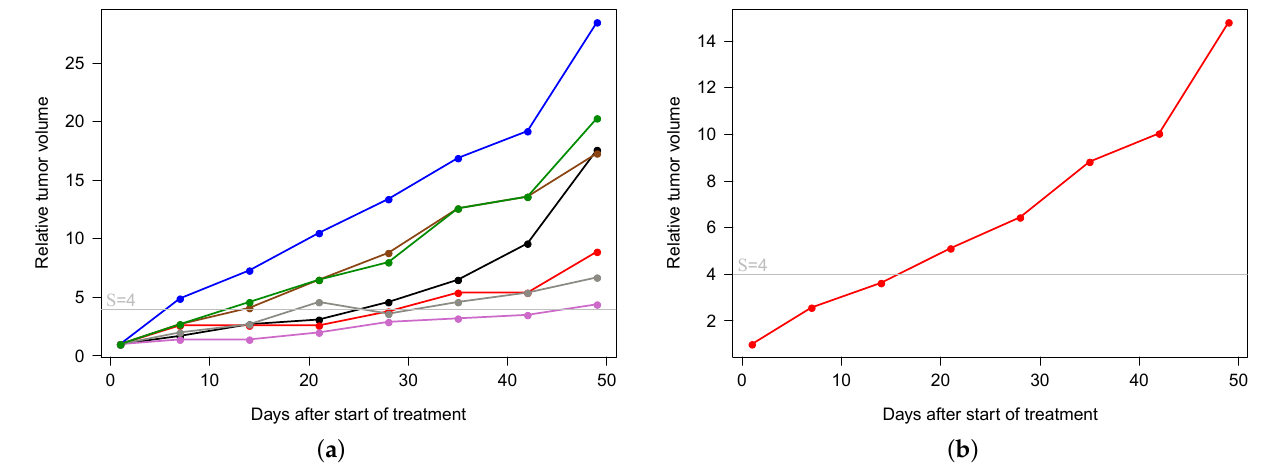
Figure 1. ( a ) Individual growth curves and ( b ) mean growth curve of the relative volume of the tumor BC297MONp5in the group treated with cyclophosphamide +